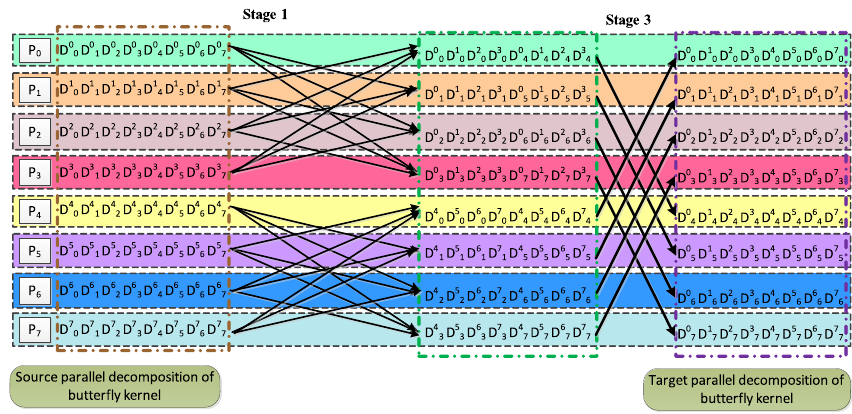
Figure 12. An example of the adaptive data transfer library with eight processes, where stage 2 of the butterfly implementation is skipped and replaced by P2P communication of three MPI messages per